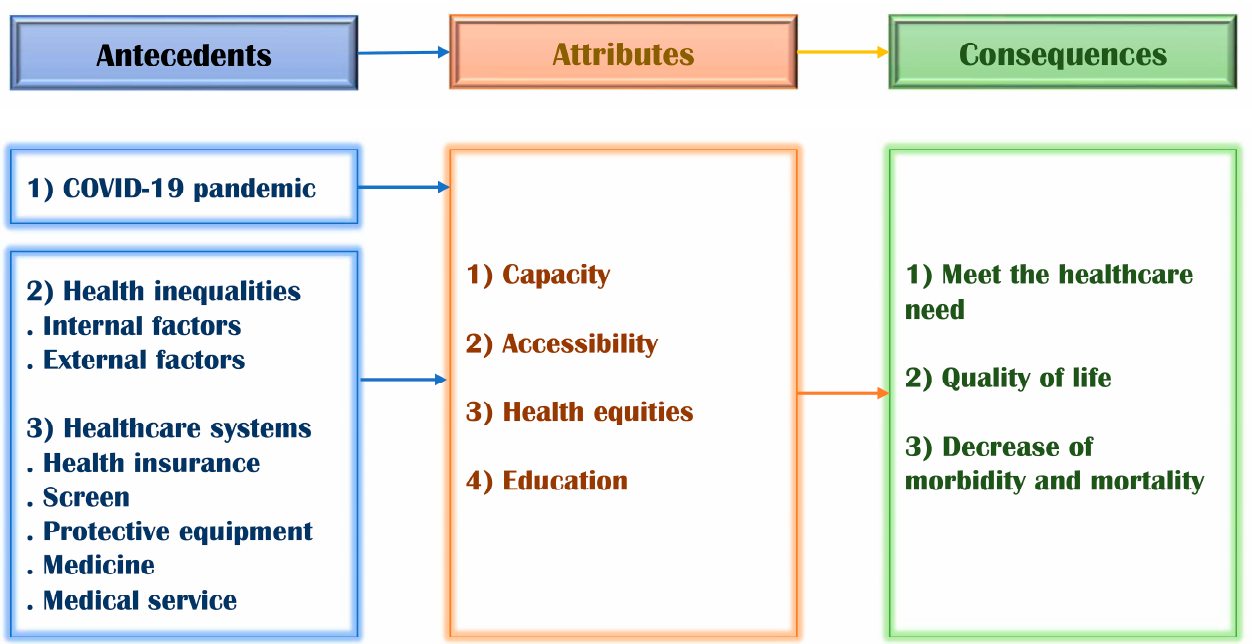
Figure 3. Concept diagram of “a healthcare safety net”.